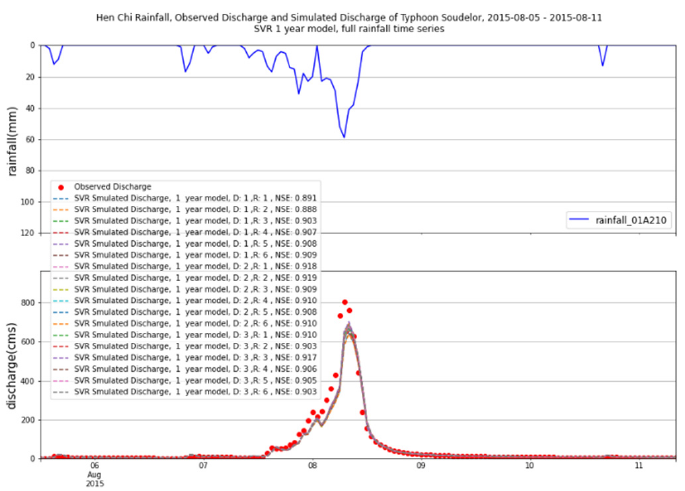
Figure 7. The testing results derived from the Type 1 SVR model using different features selection for Typhoon Soudelor. D 1 to 3 represents discharge features of the previous 1 to 3 h, while R 1 to 6 indicates rainfall features of the previous 1 to 6 h.